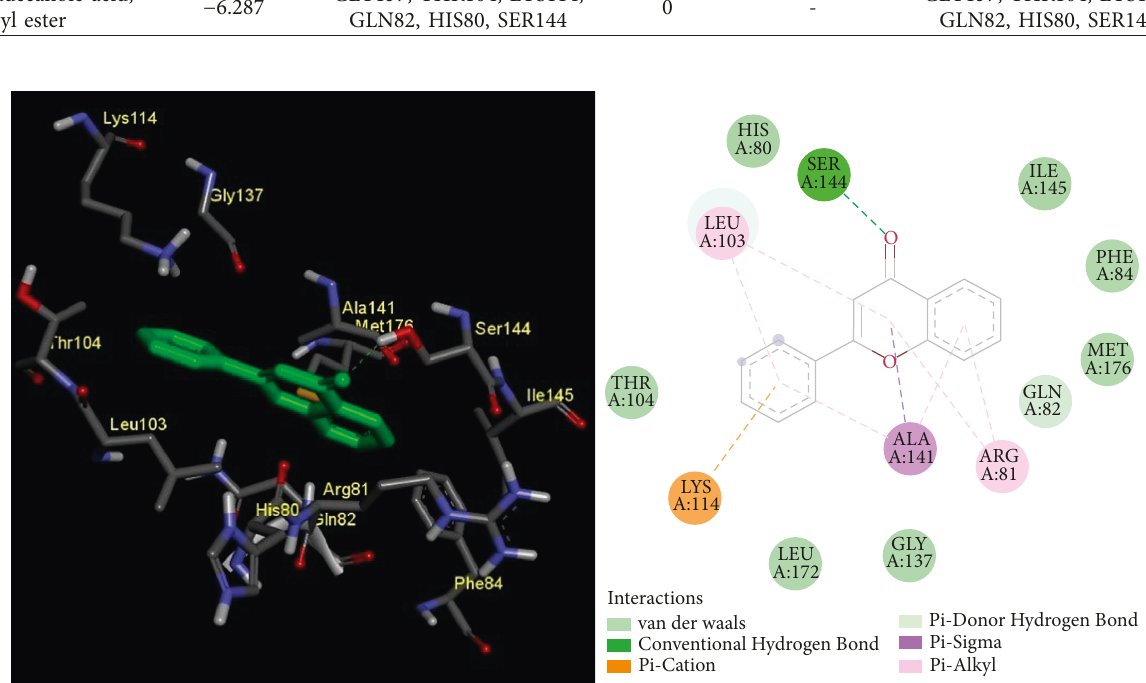
Figure 7: 2D and 3D interactions of flavone of binding score − 7.160 Kcal/mol against lipase of Malassezia restricta (Table 5). The eugenol has formed two conventional hy- drogen bonds with ALA111, TYR200 and also formed van